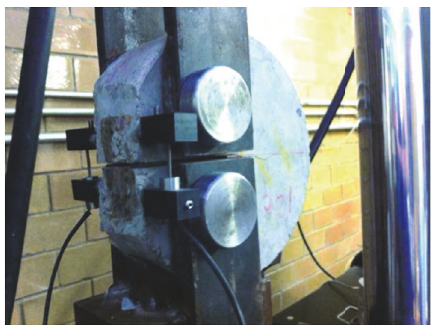
Figure 3: Specimen mounted in the machine